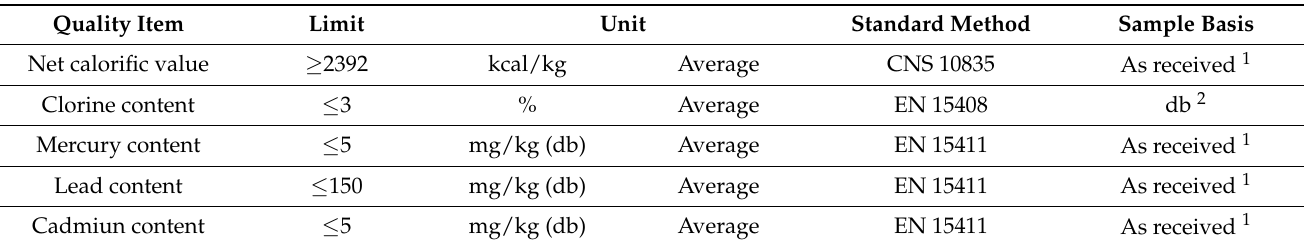
Figure 6. Variation in the reported amounts of waste wood in Taiwan during the period of 2010–2018 [29]. Table 6. Quality standards of solid recovered fuel (SRF) in Taiwan. Table 6. Quality standards of solid recovered fuel (SRF) in Taiwan.